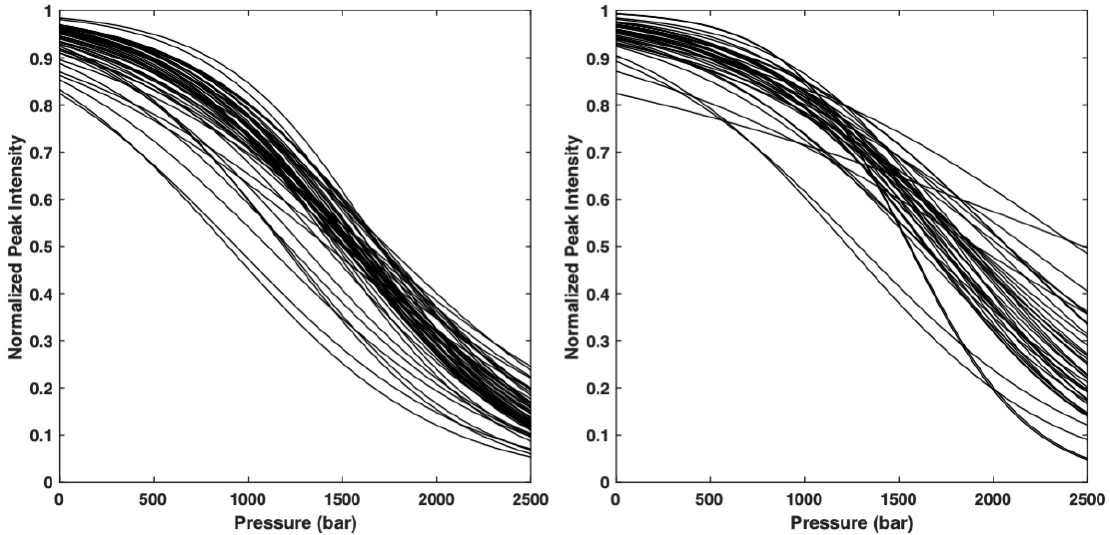
Figure 2. Overlay of the normalized residue-specific denaturation curves as obtained from the fit of the pressure-dependent sigmoidal decrease in the native cross-peak intensities in the HSQC spectra of AVR-Pia ( left ) and AVR-Pib ( right ) with Equation (1).